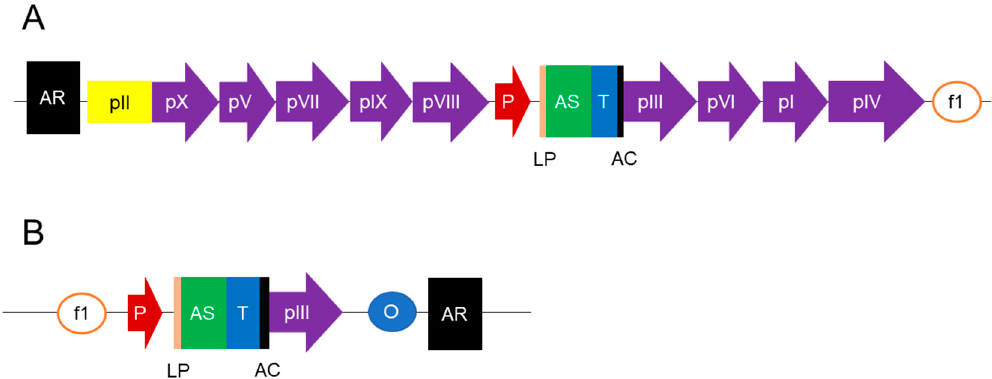
Figure 1. Construction of antibody libraries can be done either using a phage or phagemid vector. An antibody sequence (AS) is located between a leader sequence (LP) and a pIII coding sequence (pIII). Both vectors consist of a promoter (P), an antibiotic resistance (AR) gene for selection, a tag (T) for detection or purification, and an f1 origin (f1 ori) for replication of single-stranded DNA and generation of antibody-displayed phage particles. Phagemid vectors have in addition a plasmid origin (plasmid ori) for propagation in Escherichia coli . An amber stop codon (AC) is essential for both phage and phagemid vectors and located in between the antibody and pIII coding sequences. Phage vectors will have the genes of the other coat proteins (pX, pV, pVII, pIX, pVIII, pVI, pI, and pIV), whereas phagemid vectors only have the pIII gene.